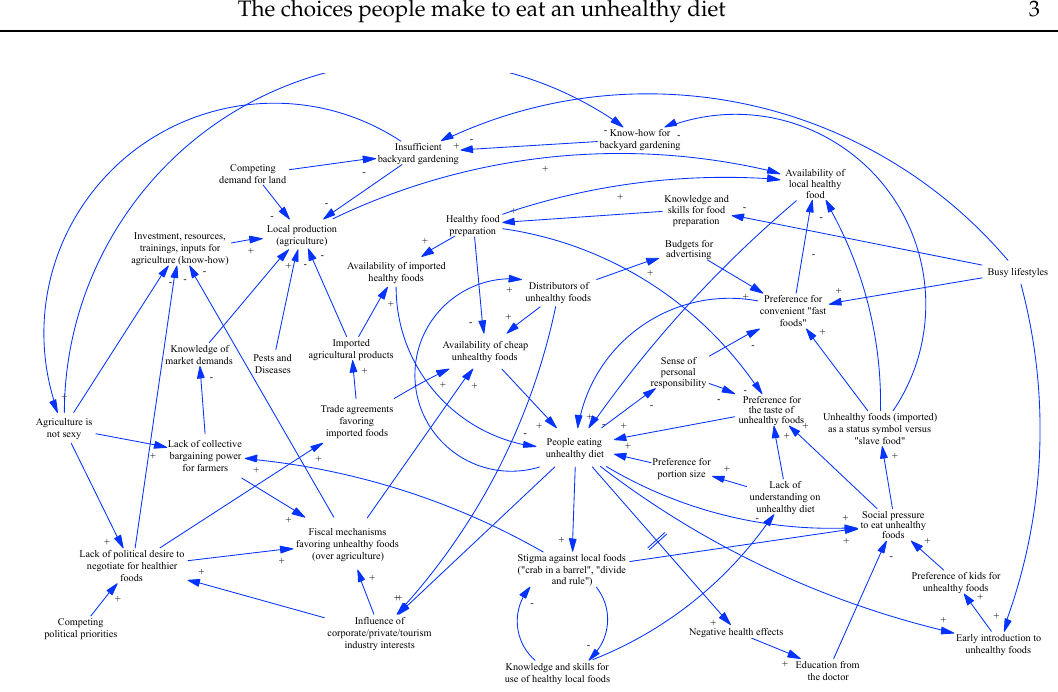
Figure 2a - St Ki=s preliminary causal loop diagram for unhealthy eating Figure A3. St. Kitts preliminary causal loop diagram for unhealthy eating. Table A2. Summary of places to intervene SKN / SVG workshop. Area for intervention Key